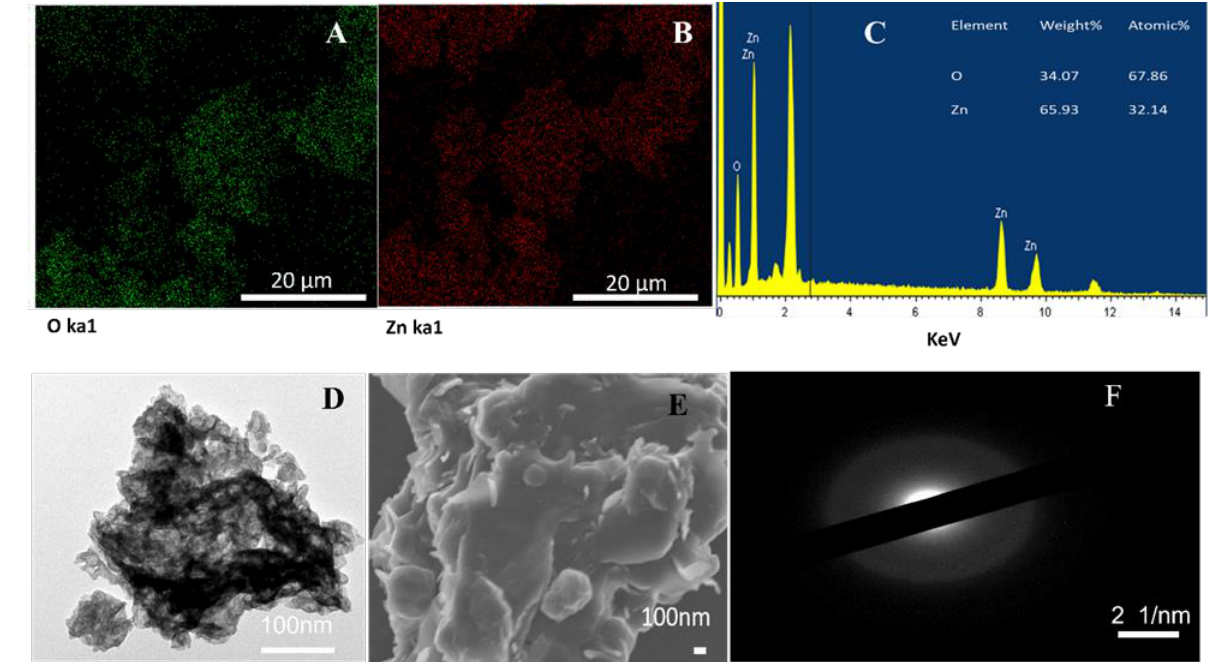
Figure 2. Structural characterization of ZnO NPs by electron microscopy prepared from P. ostreatus : ( A , B ) are EDS elemental maps (20 kV) of oxygen (Ka1) and zinc (Ka1) emission lines, respectively; ( C ) EDX analysis (20 kV) of O Ka1 and Zn Ka1; ( D ) TEM images of synthesized ZnO NPs; ( E ) SEM micrograph image of synthesized ZnO NPs; and ( F ) SAED pattern of ZnO NPs.